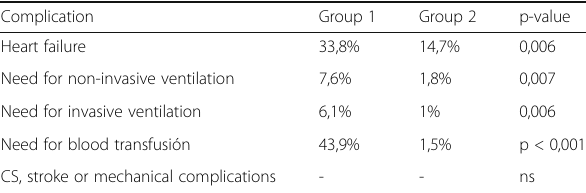
Table 2 (abstract 000533). In-hospital complications and mortality